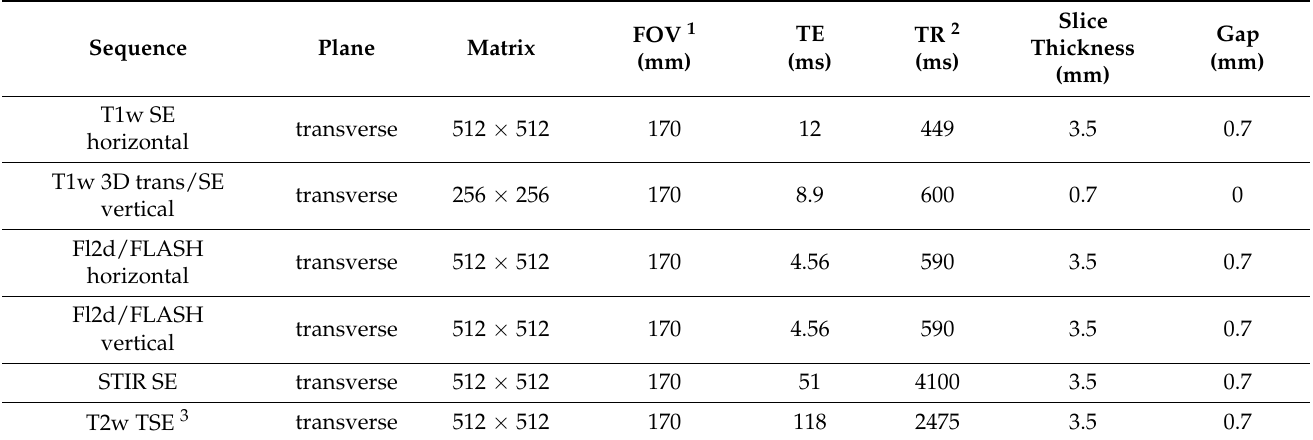
Table 2. MRI sequences used for 3 T high-field